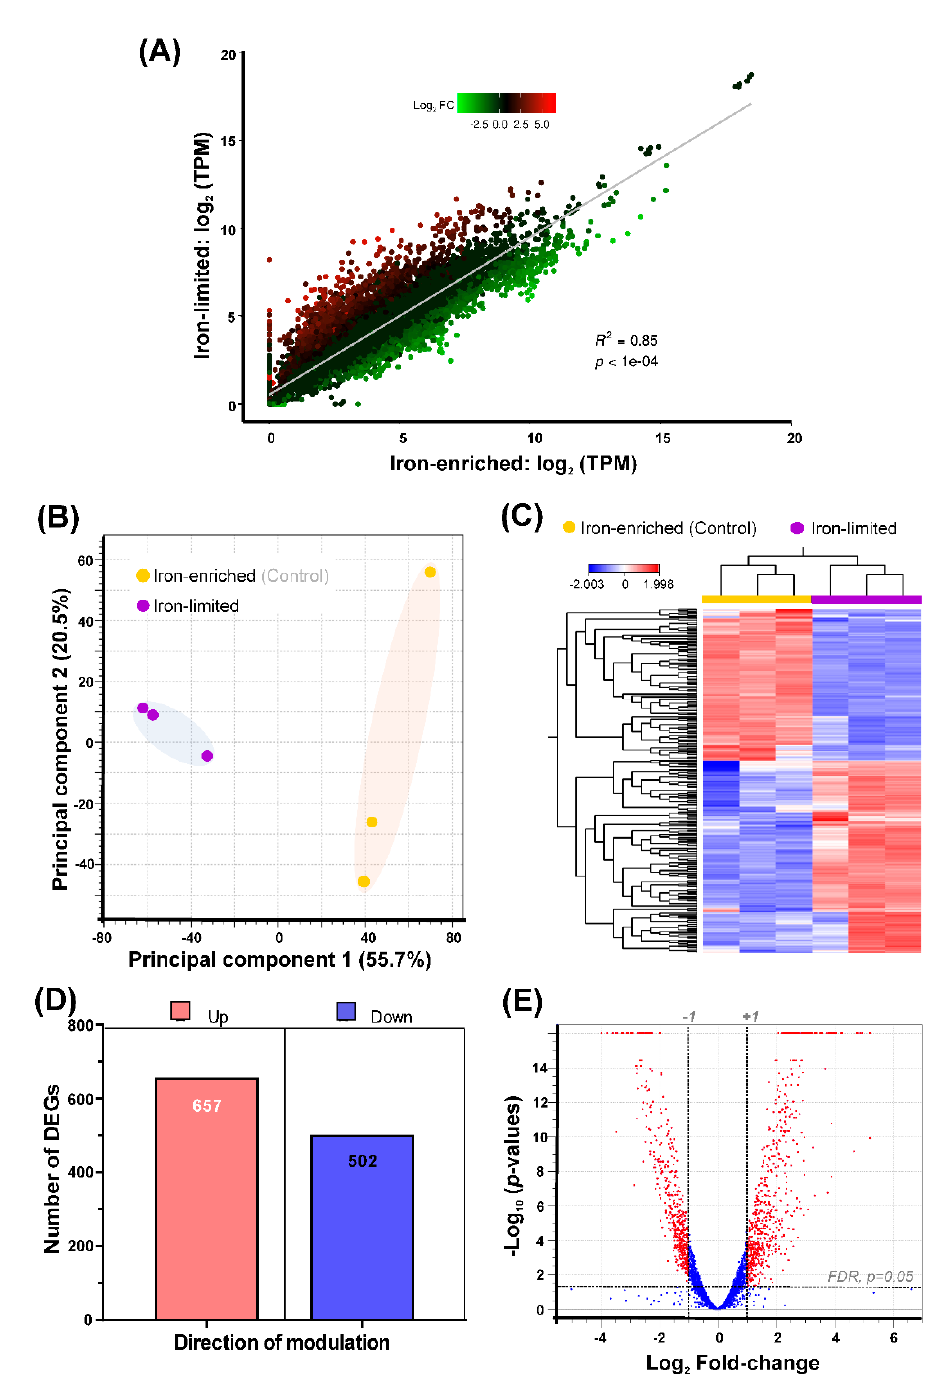
Figure 6. Global transcriptomic profiling of Pseudomonas sp. J380 by RNA-Seq. A total of six RNA libraries comprising three biological replicates for two different (iron-enriched versus iron-limited) conditions were included in the RNA-Seq experiment. ( A ) Scatter plot of RNA-seq expression under iron-enriched and iron-limited conditions. Each dot represents a gene; where red, green and black represent up-, down-regulated and non-differentially expressed genes. ( B ) Principal component analysis (PCA) of bacterial samples from iron-enriched and iron-limited conditions based on the expression of all datasets. ( C ) Heat map clustering of differentially-expressed genes (DEGs); color bars below the horizontal cluster indicate control (iron-enriched, yellow) and experimental (iron-limited, purple) samples. ( D ) The number of biologically significant DEGs with log 2 FC ≥ |1| and FDR, p ≤ 0.05. ( E ) Volcano plot of DEGs; red dots, significant DEGs.